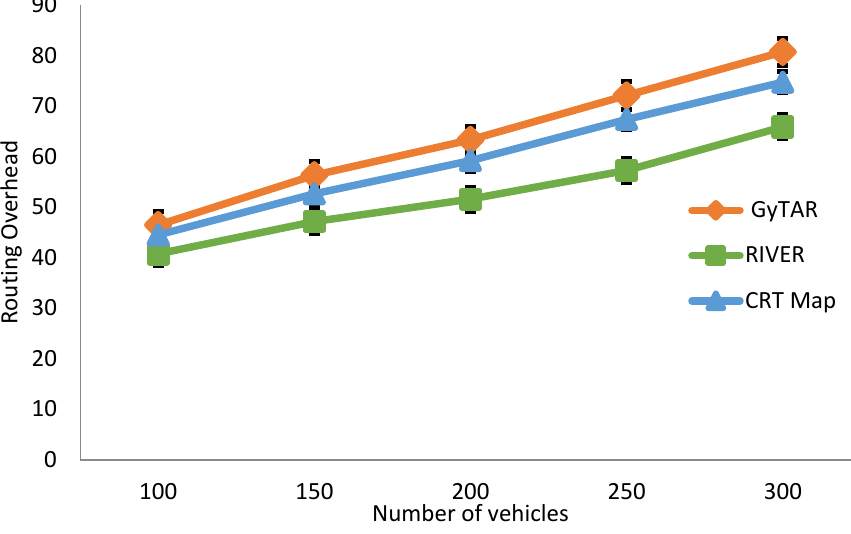
Figure 12. Routing Overhead (per route) vs. Number of vehicles.